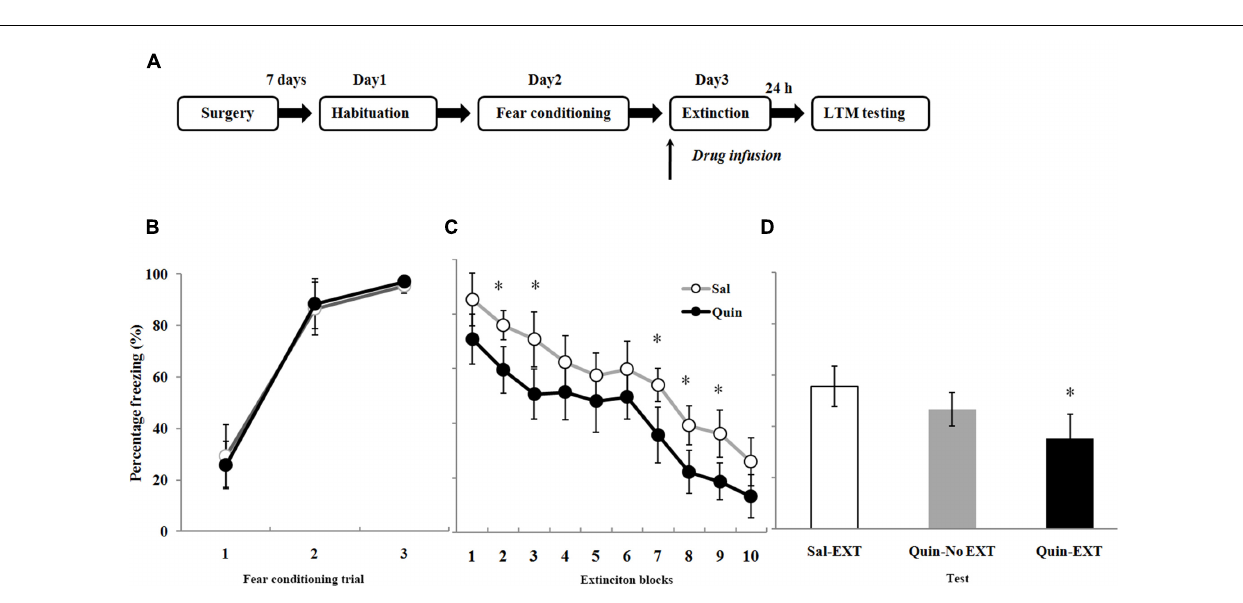
FIGURE 4 | The effects of quinpirole microinfusion to the BLA before extinction training on long-term memory (LTM). (A) The protocol for drug administration. (B) Rats were presented with three pairings of tone and footshock in the conditioning chamber. (C) Administration of quinpirole before extinction training facilitated within-session extinction ( ∗ P < 0.05). (D) The freezing levels of LTM after fear extinction training following quinpirole administration. The LTM level of the Quin-EXT group ( n = 15) was also significantly lower than that of the Sal-EXT group I ( n = 13, ∗ P <